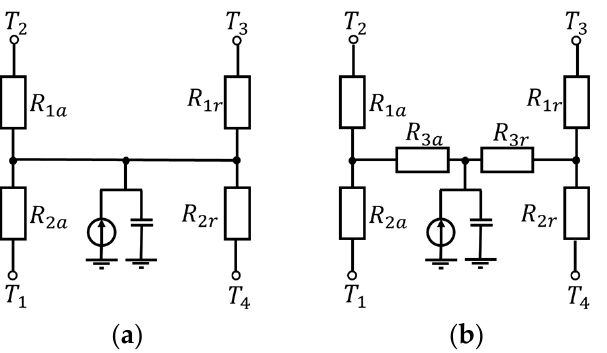
Figure A1. Cylindrical components in electrical machines. ( a ) Whole component and ( b ) with angular spans α . r 1 , r 2 and L are the radius of inner surface, radius of outer surface and stack length, respectively. T 1 , T 2 , T 3 and T 4 are the temperatures of the front, rear, outer and inner surfaces.